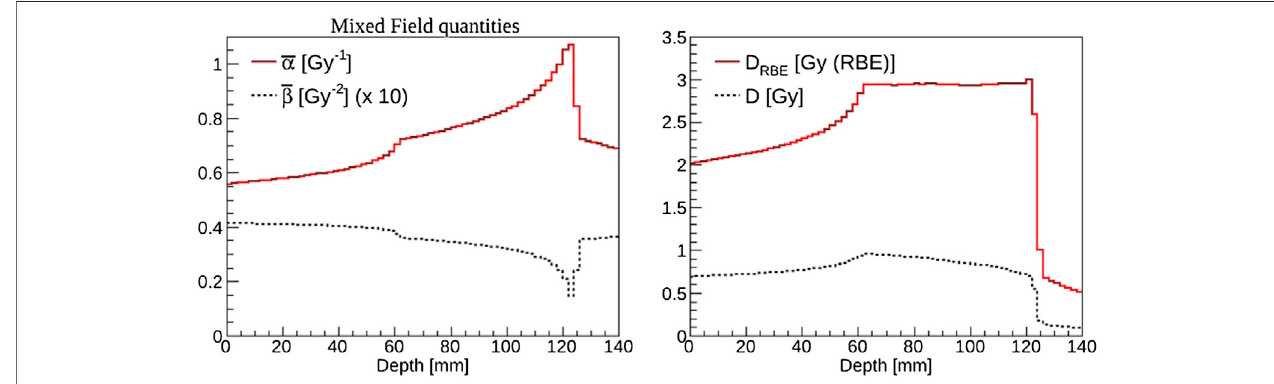
FIGURE 6 | Example of biological weighting of dose performed with FLUKA [135] in the case of a carbon ion spread-out Bragg peak for a cube-shaped target of side6 cmcenteredat9 cminwater.Leftpanel: α (solidline)and β (dashedline)calculatedasafunctionofdepthinwater.The β resultshave beenrescaled byafactorof ten for display purposes. Right panel: absorbed dose (dashed line) and D RBE (solid line) values calculated as a function of depth in water.